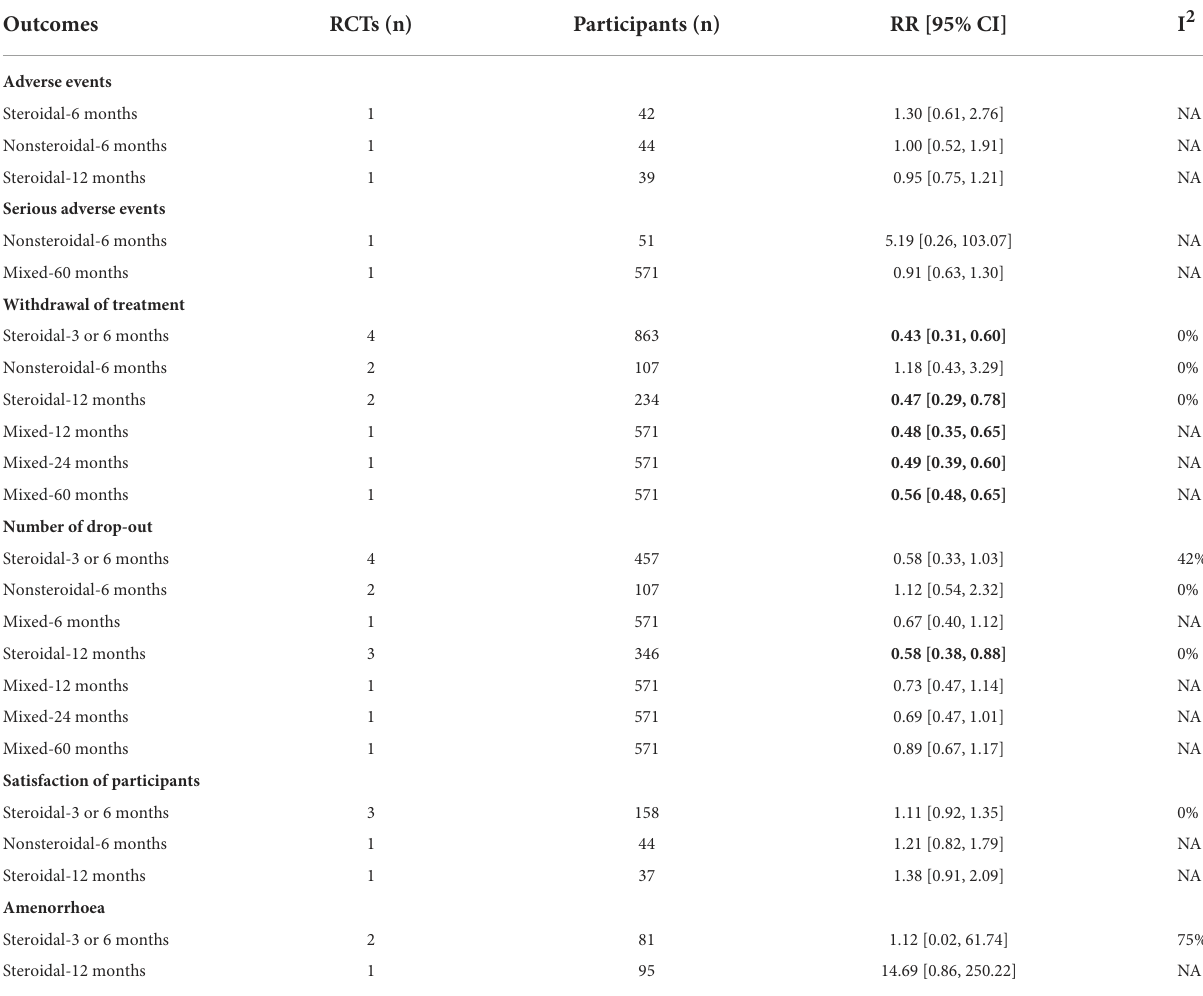
TABLE 4 Results summary of meta-analyses for secondary